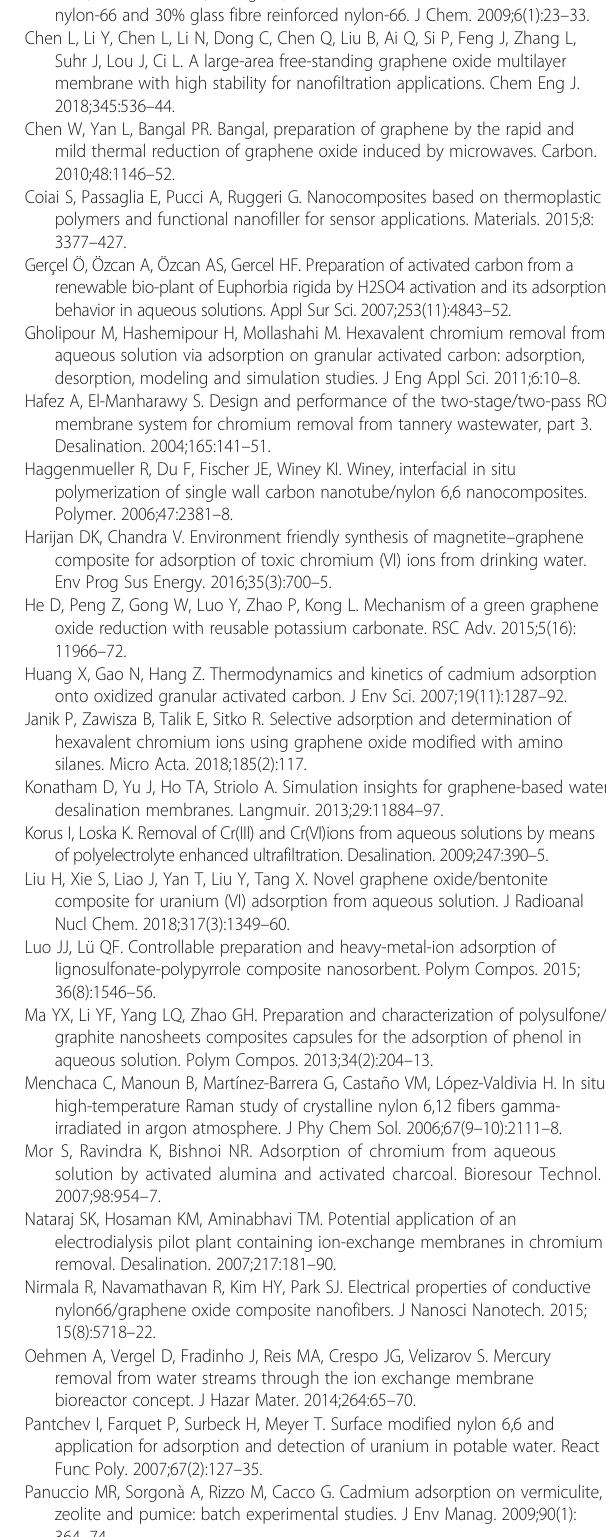
Table 3 Kinetic parameters of Cr (VI) adsorption N6,6/GO C q Pseudo-first-order o e exp